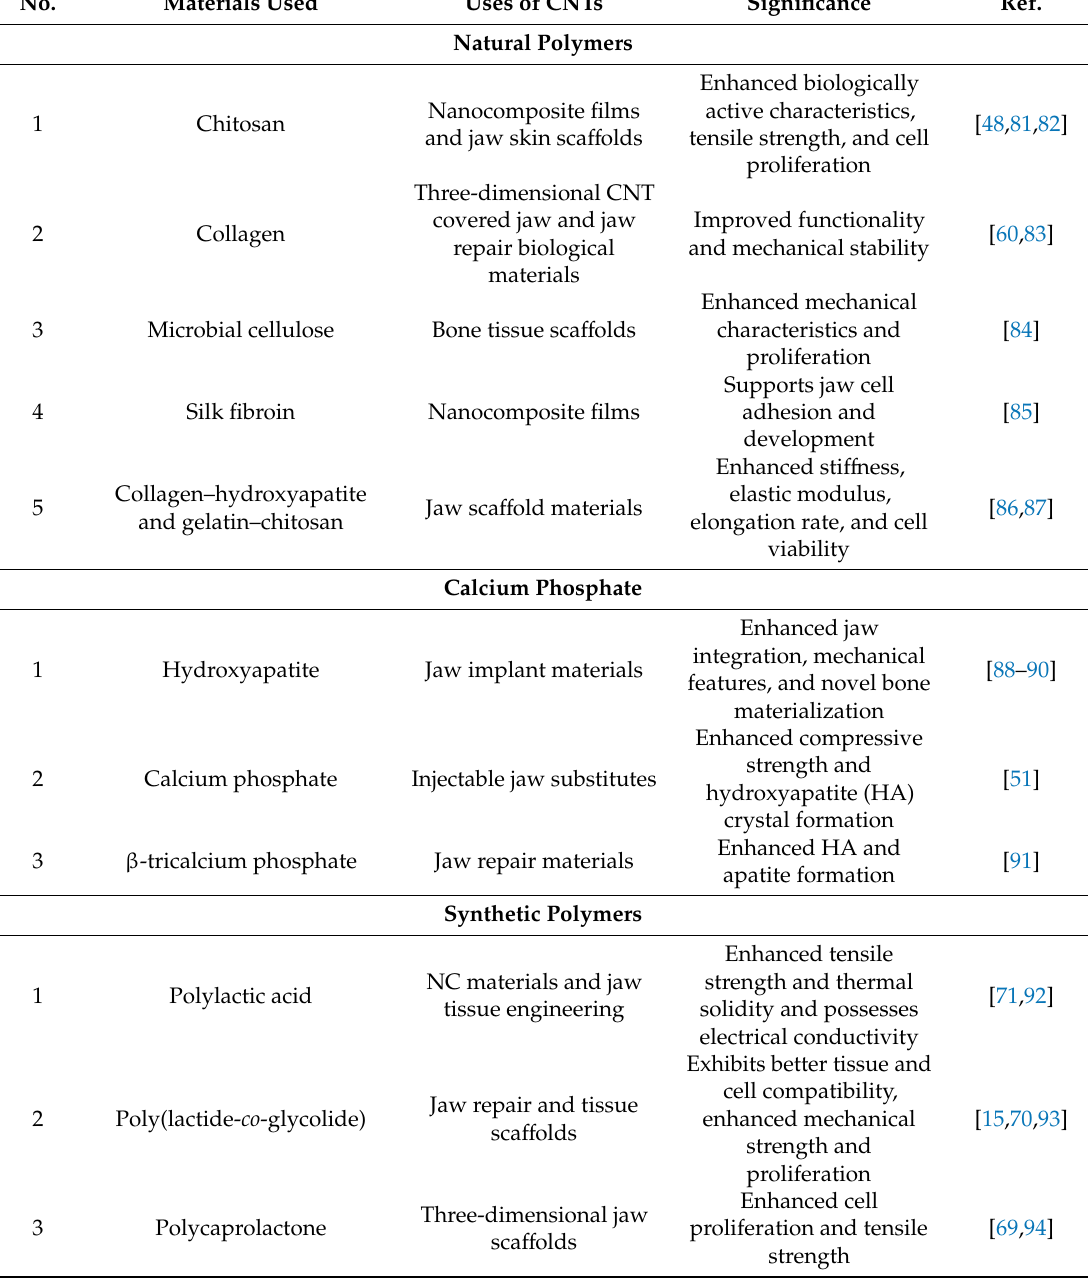
Table 1. CNT applications in bone tissue